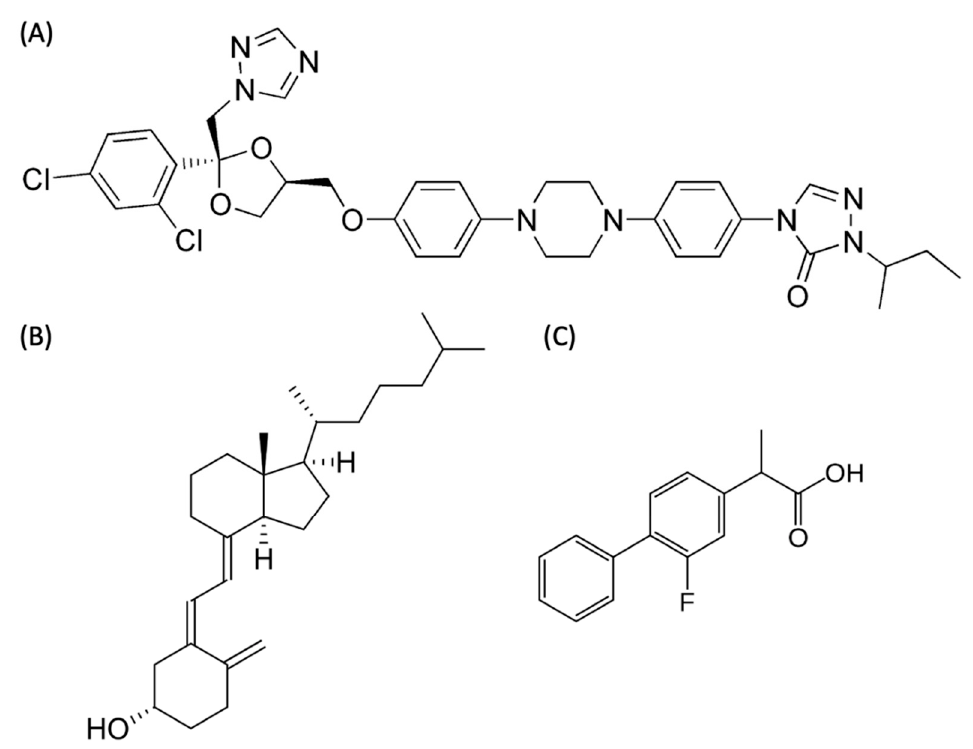
Figure 1. Chemical structures of ( A ) itraconazole (ITZ), ( B ) cholecalciferol (VitD3), and ( C ) flurbiprofen (FLU). Table 1. The physicochemical properties of model drugs.